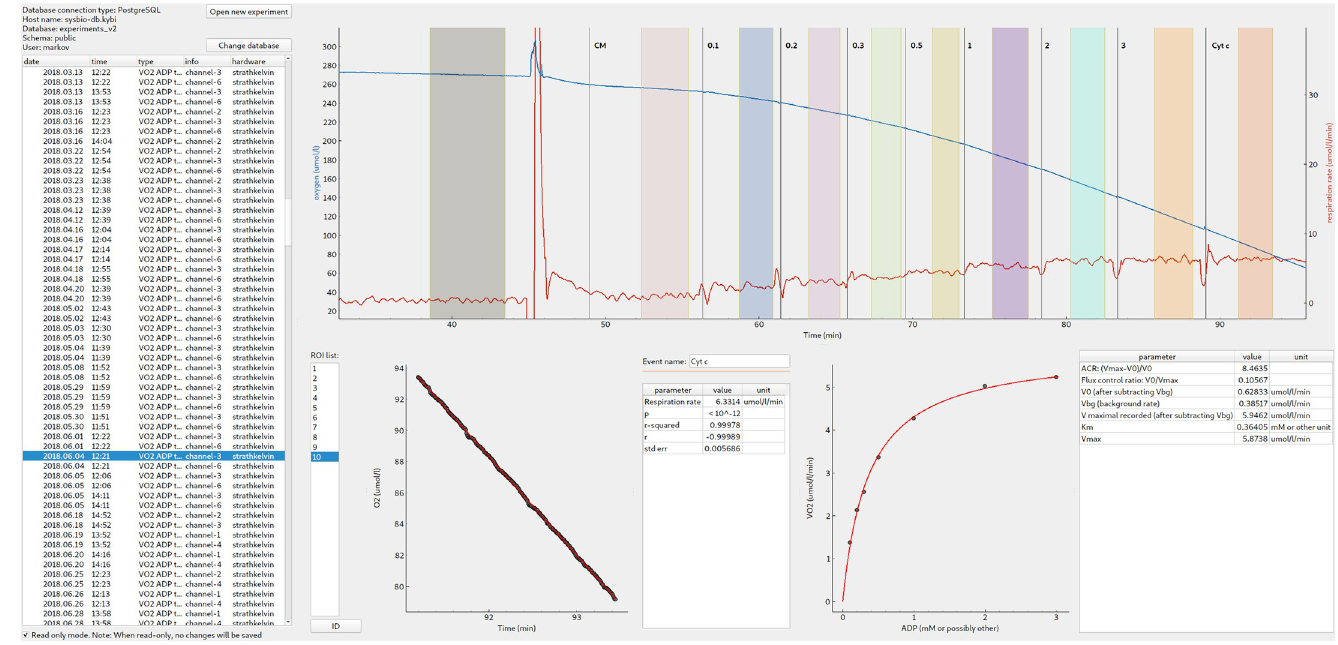
Fig 1. Overview of the graphical user interface. See main text for